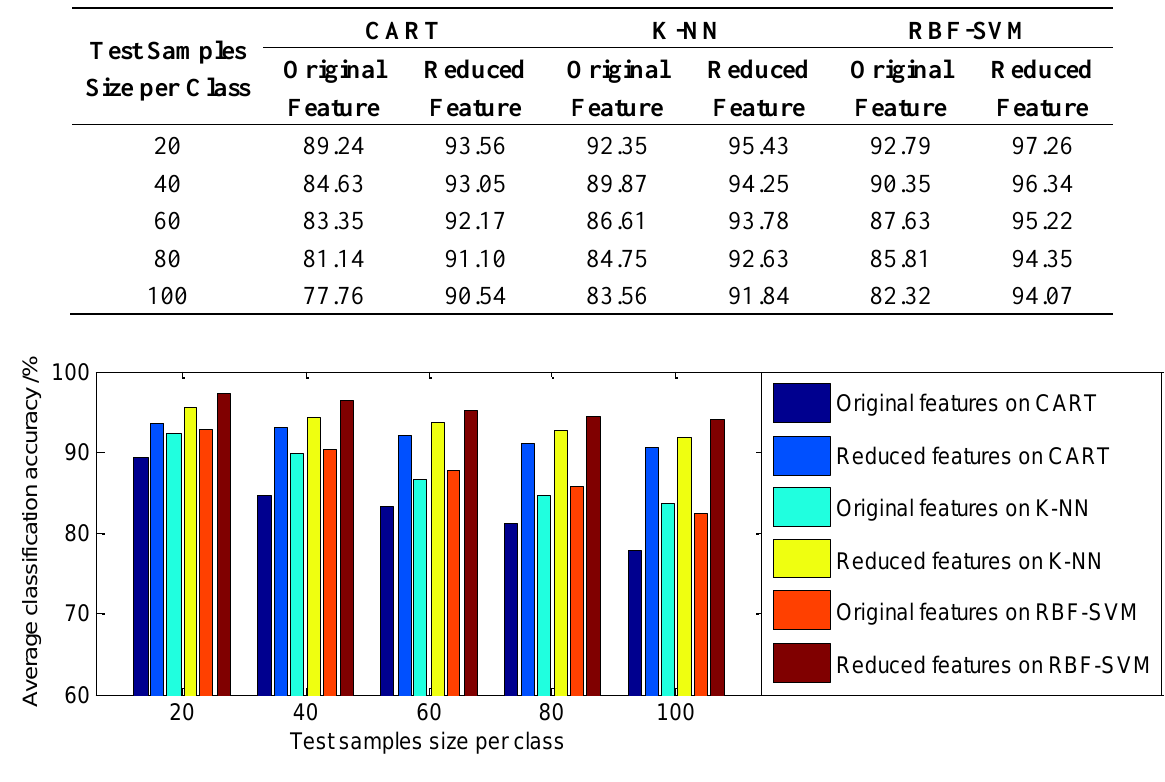
Figure 11. The comparison of the average classification accuracy with different features dataset on classifiers using statistical